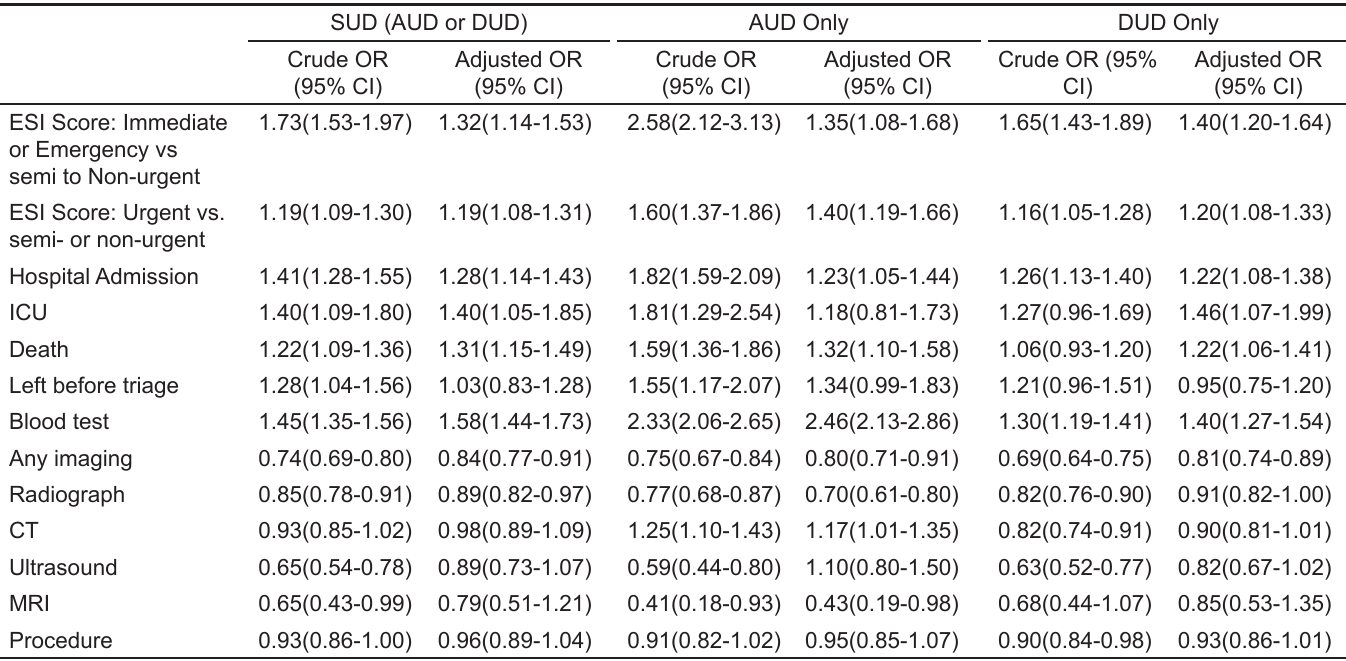
Table 5. Odds ratio of Emergency Severity Index, hospital admission, ICU admission, medical resources utilization for patients with vs without substance use disorder,